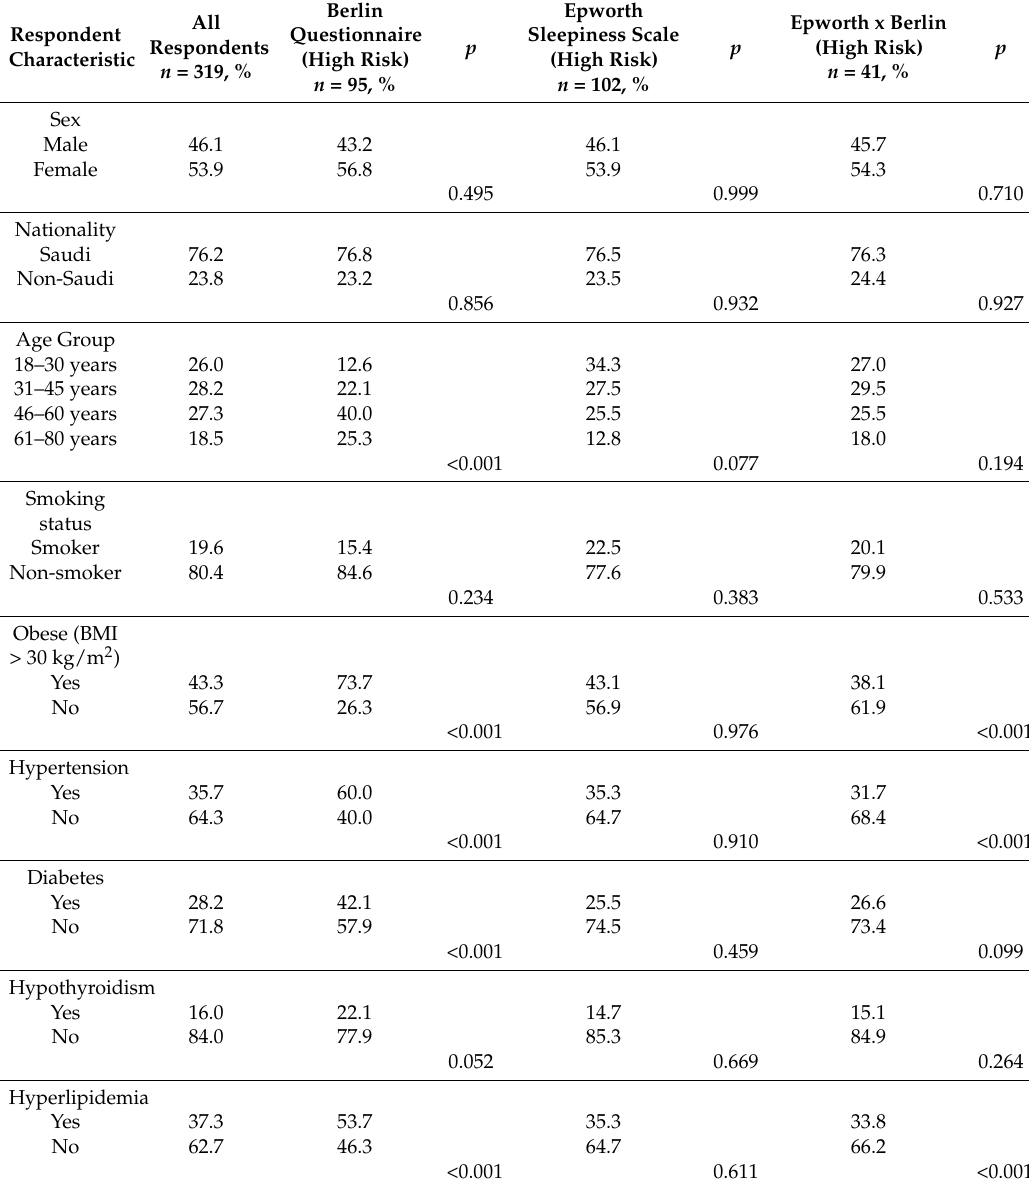
Table 1. Descriptive statistics of study respondents assessed as at high risk of sleep